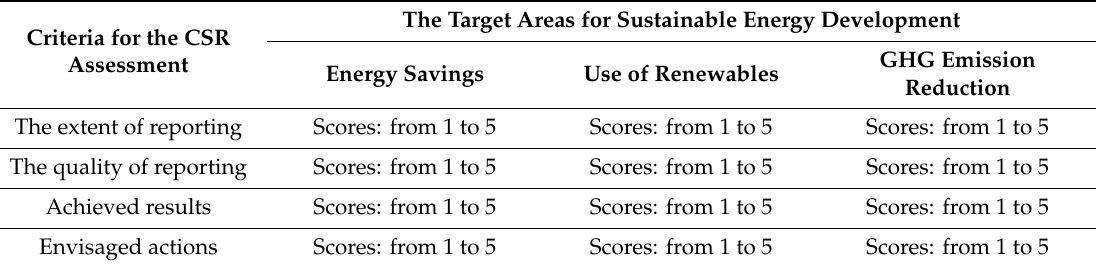
Table 6. The criteria for the assessment of CSR of utilities. Source: created by the authors. Criteria for the